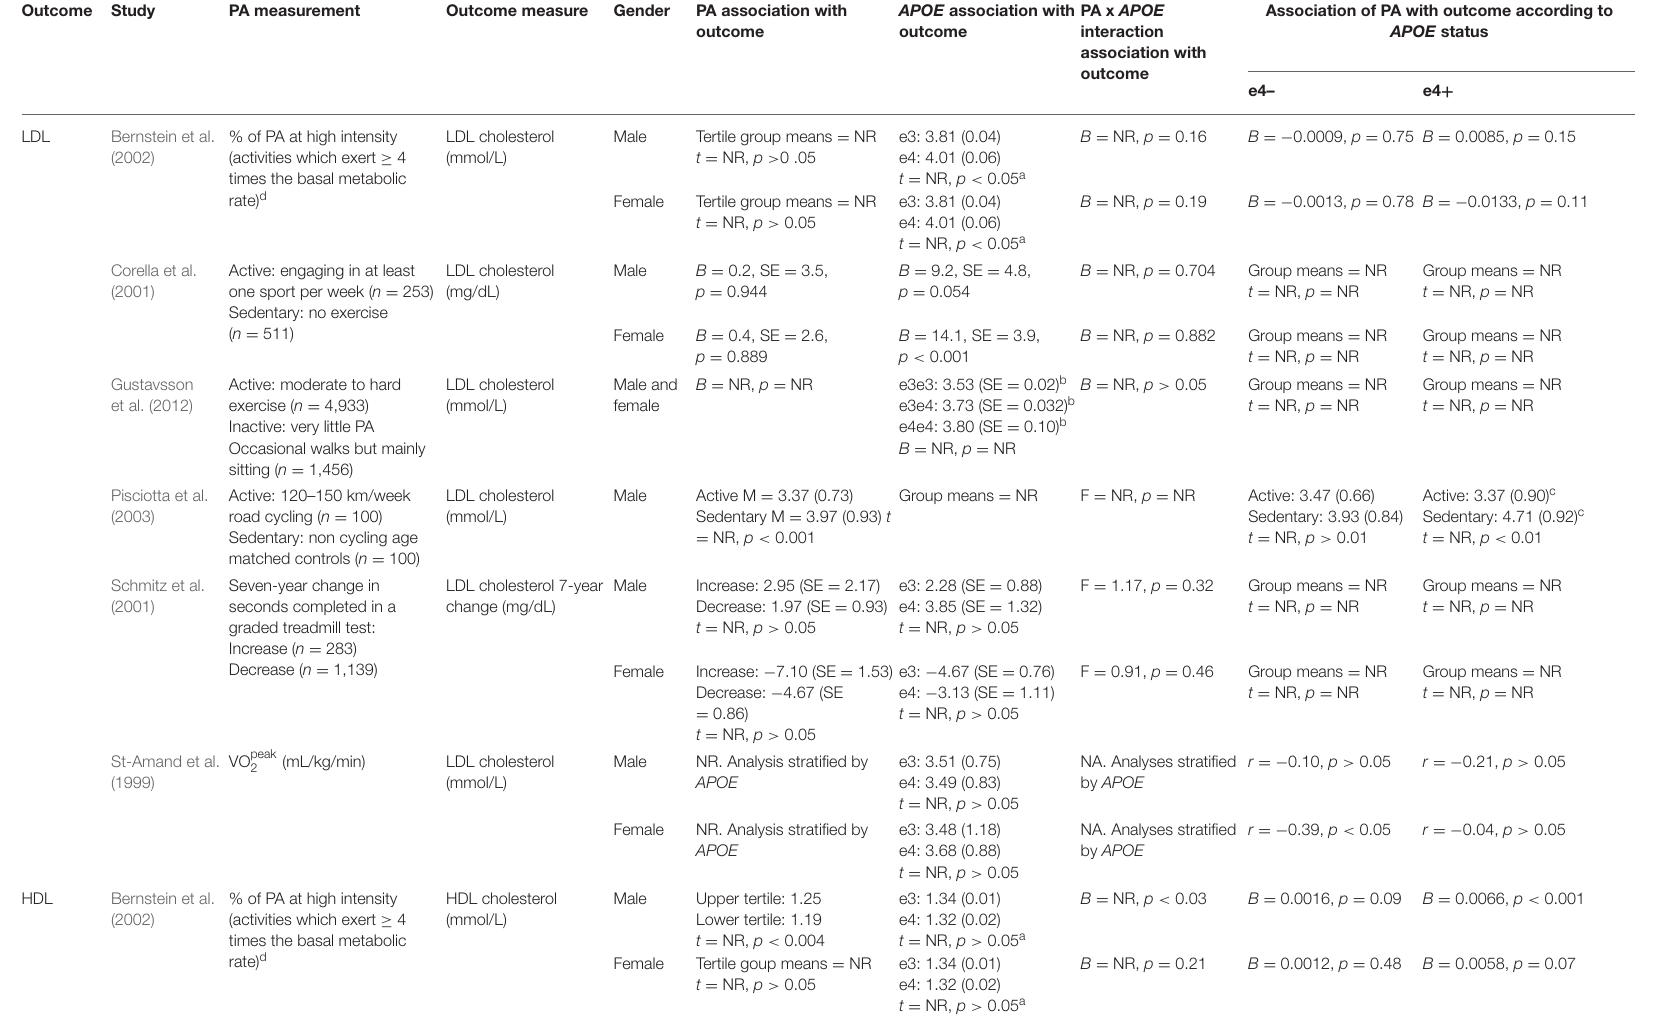
TABLE 2 | Associations between physical activity and lipid profile. Outcome